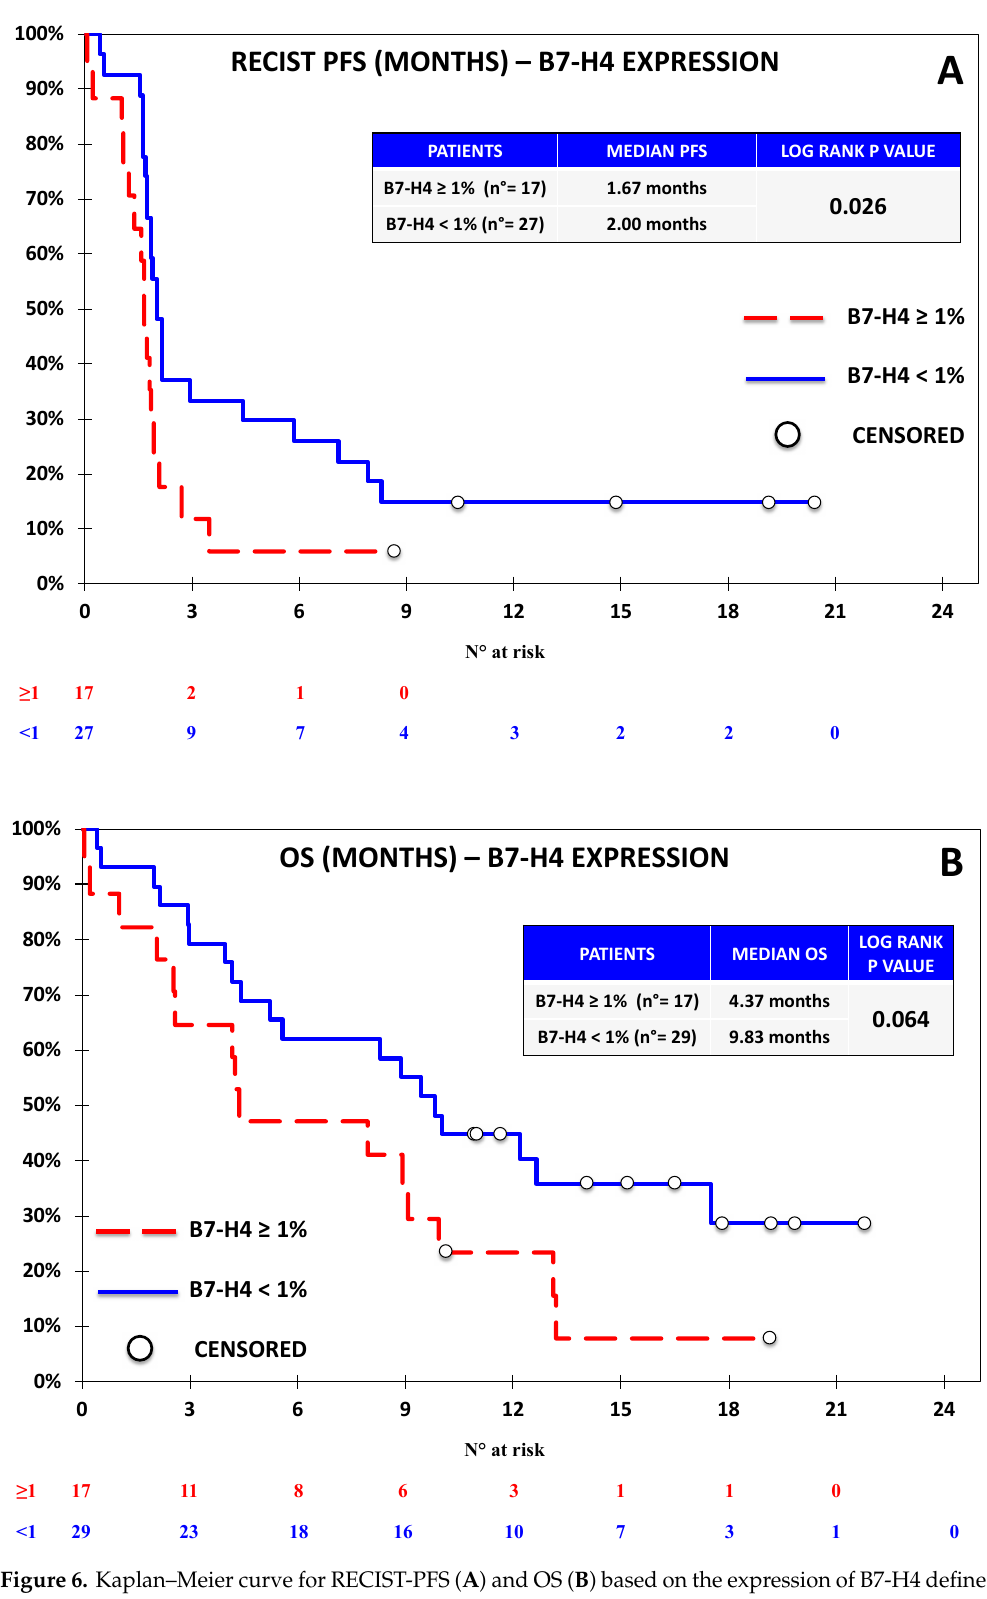
Figure 6. Kaplan–Meier curve for RECIST-PFS ( A ) and OS ( B ) based on the expression of B7-H4 defined as ≥ 1% vs. < 1% in the Nivolumab Cohort. The expression of B7-H4 was significantly associated with shorter PFS and non-significantly associated with shorter OS, although the difference was close to significance ( p -value = 0.064).